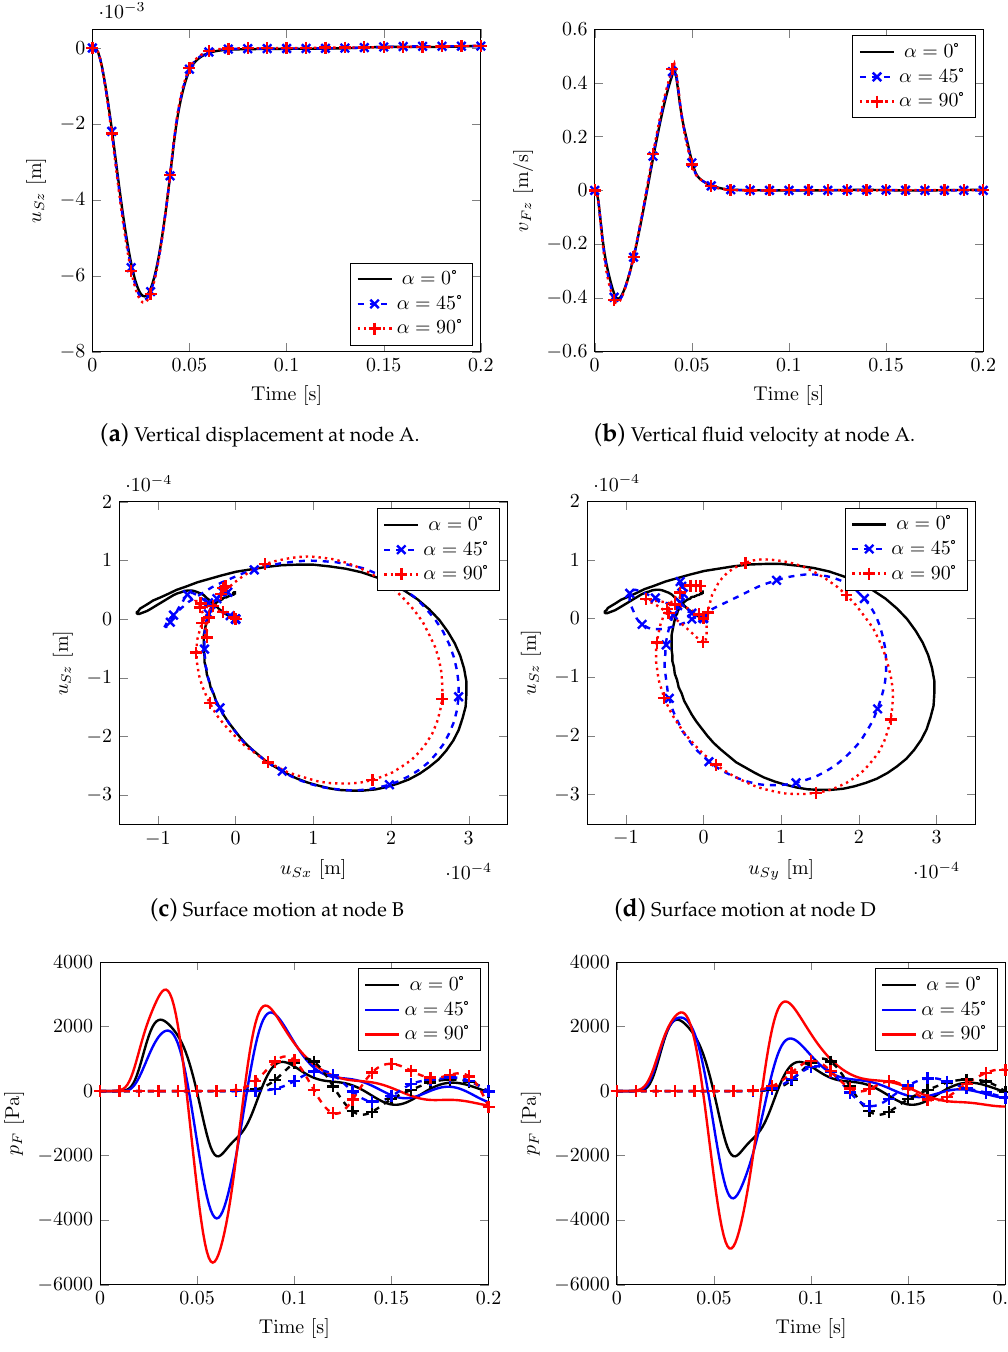
Figure 17. Effect of Biot’s coefficient tensor: main